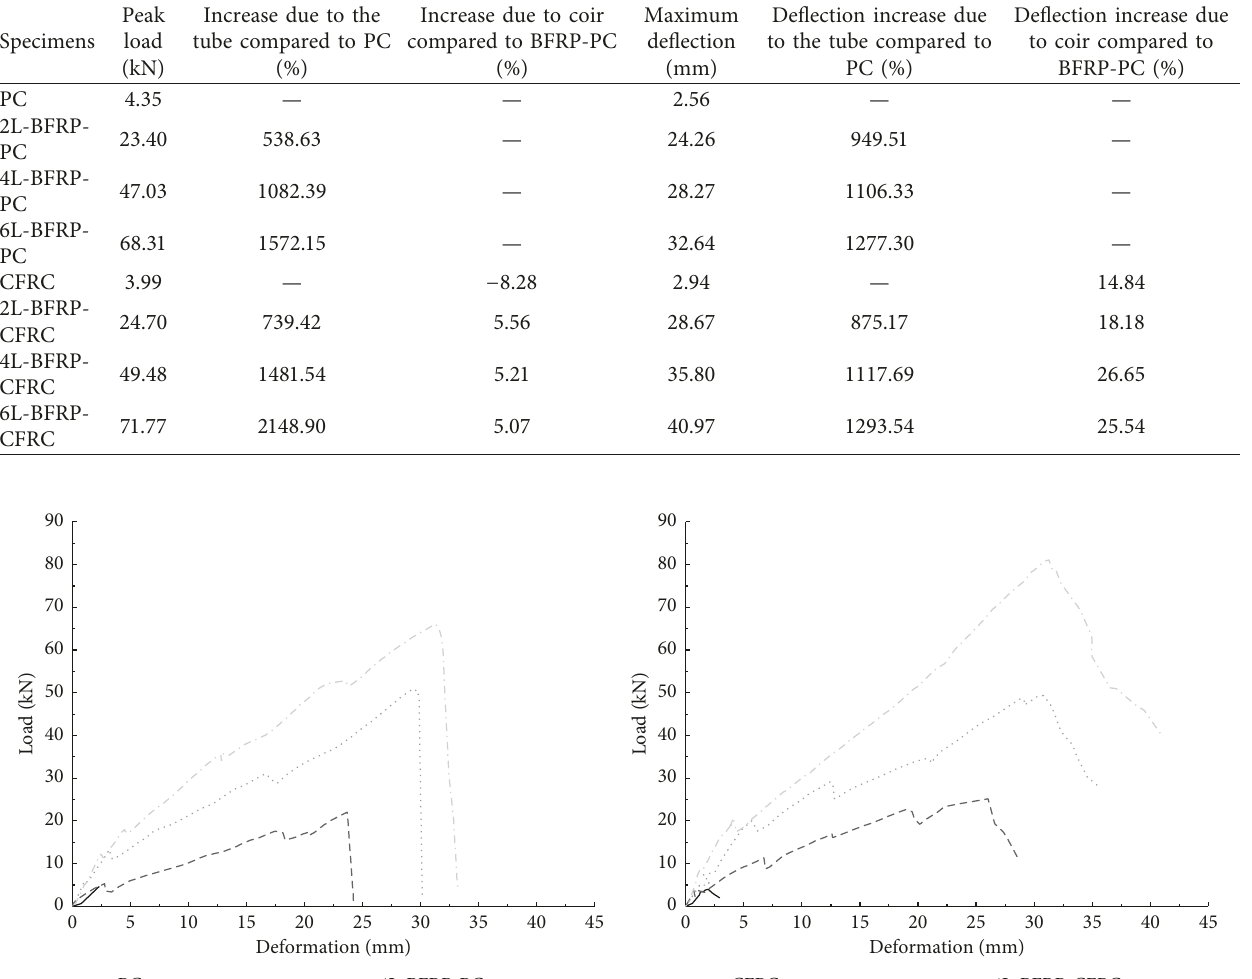
Table 3: Average test results of long cylindrical specimens under flexure.